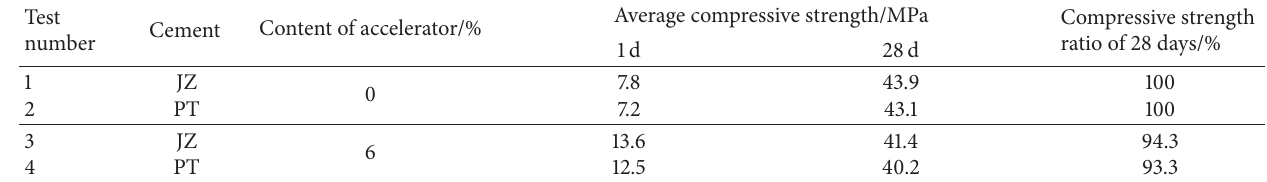
Table 14: Effects of WT-1 type accelerator on the strength of cement paste.